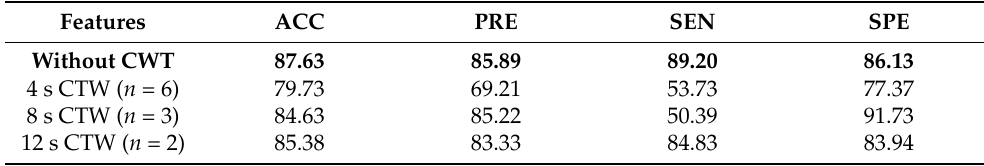
Table 6. AF detection performance based on time and time-frequency features with and without CTW by means of RF.